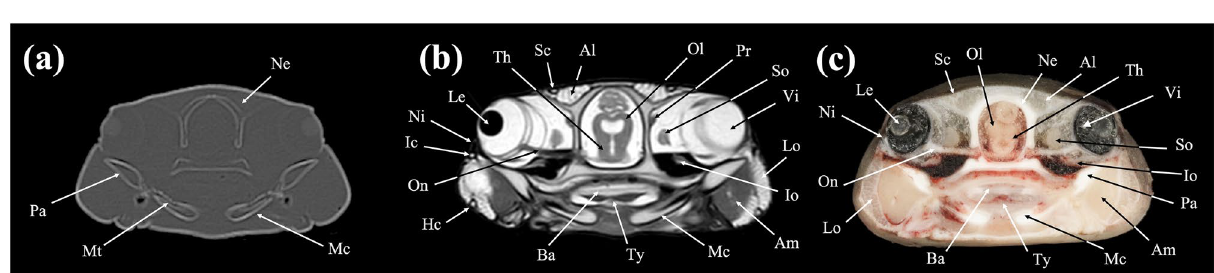
Figure 3. Transverse ( a ) CT, ( b ) MR, and ( c ) cryosection images of a banded houndshark ( Triakis scyllium ) at level 3 of Fig. 25. Al Ampullae of Lorenzini, Am Adductor mandibularis, Ba Basihyal cartilage, Hc Hyomandibular canal, Ic Infraorbital canal, Io Inferior obliquus, Le Lens, Mc Meckel’s cartilage, Mt Mandibular teeth, Ne Neurocranium, Ni Nictitating fold, Ol Optic lobe, On Optic nerve, Pa Palatoquadrate, Pr Posterior rectus, Sc Supraorbital canal, So Superior obliquus, Th Thalamus, Ty Thyroid, Vi Vitreous